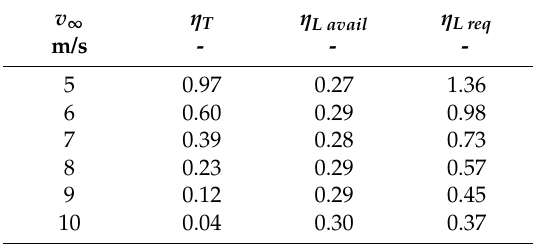
Table 3. Normalized thrust and available and required normalized lift along the take-off